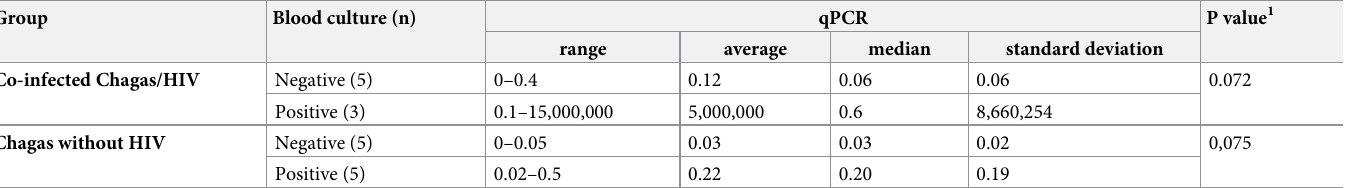
Table 4. Comparison between blood culture and qPCR.